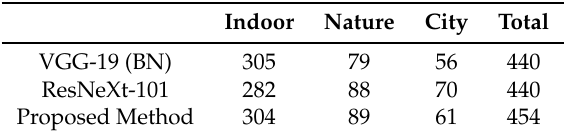
Table 5. Comparison between best CNNs and the proposed method. The correct number of images per class in our custom